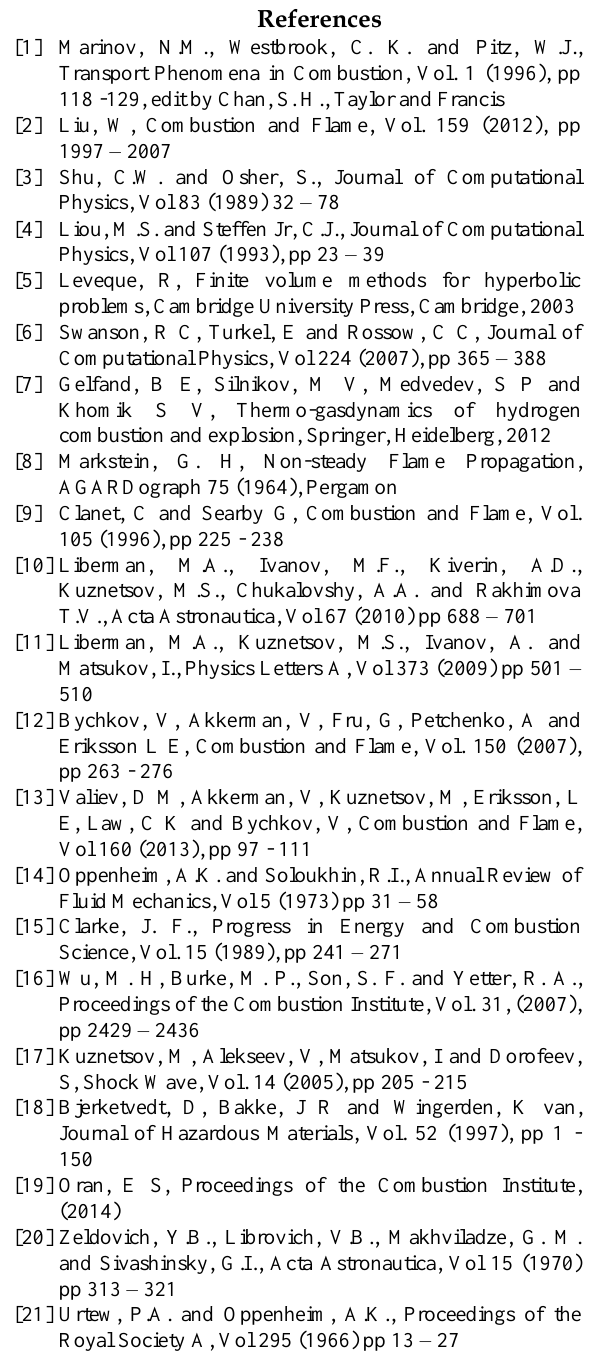
Figure 7. They are at the time instants of 230µs, 240µs and 250µs, respectively (transition to detonation starts at 262 µs).